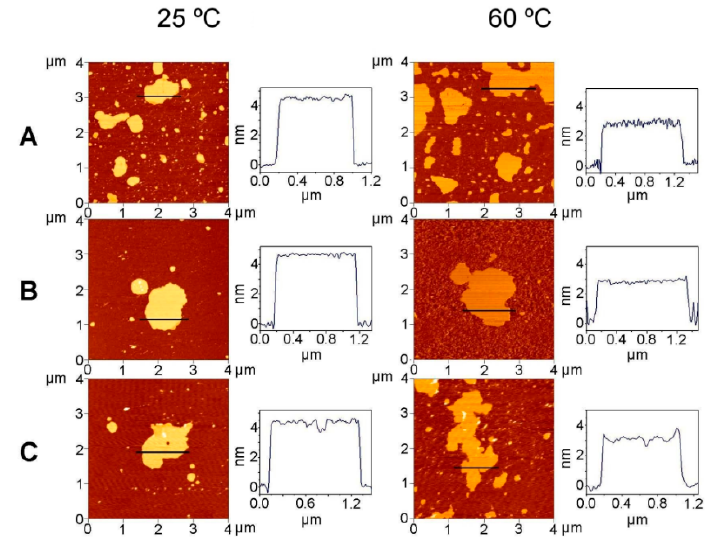
Figure 8. Topology of supported bilayers of DMPE systems containing different concentrations of TMCG as visualized by AFM. Pure DMPE ( A ); DMPE/TMCG 0.07 mol fraction ( B ); and DMPE/TMCG 0.25 mol fraction ( C ). The samples were scanned at 25 °C (gel phase) and 60 °C (liquid crystalline phase). Plots on the right correspond to the horizontal cross-sections at the indicated positions in the panels.